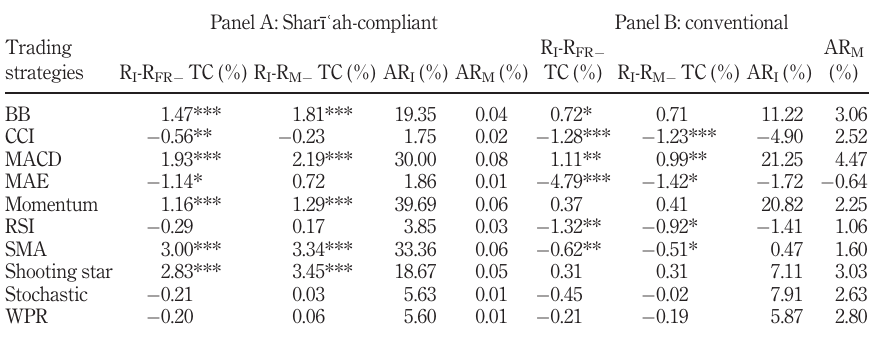
Table III. Summary of NER for all selected technical trading strategies